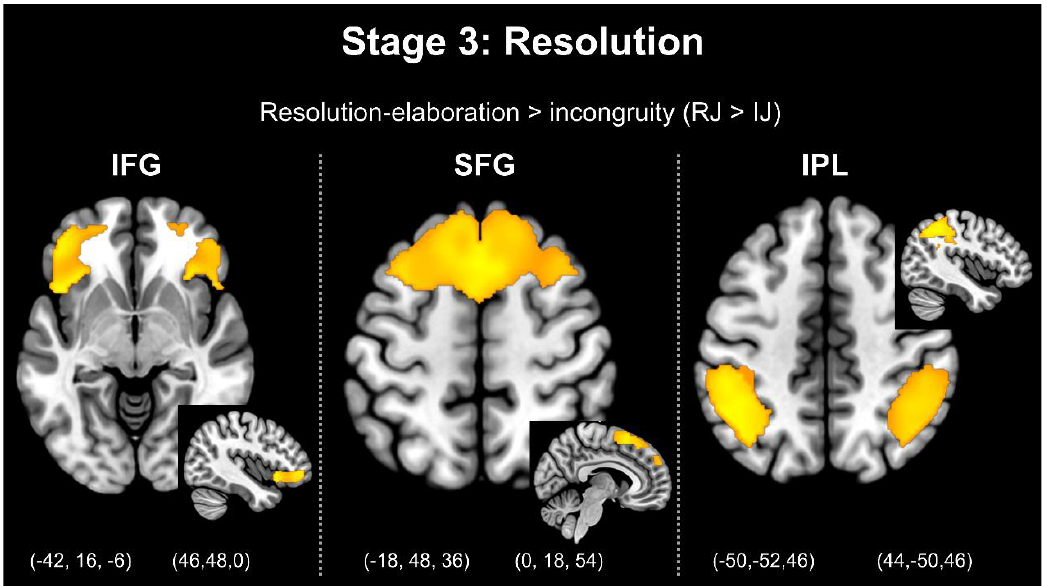
Figure 4. Stage 3: Resolution. Note: IFG = inferior frontal gyrus; SFG = superior frontal gyrus; IPL = inferior parietal lobule.